Question: Identify the chart type used in this figure.
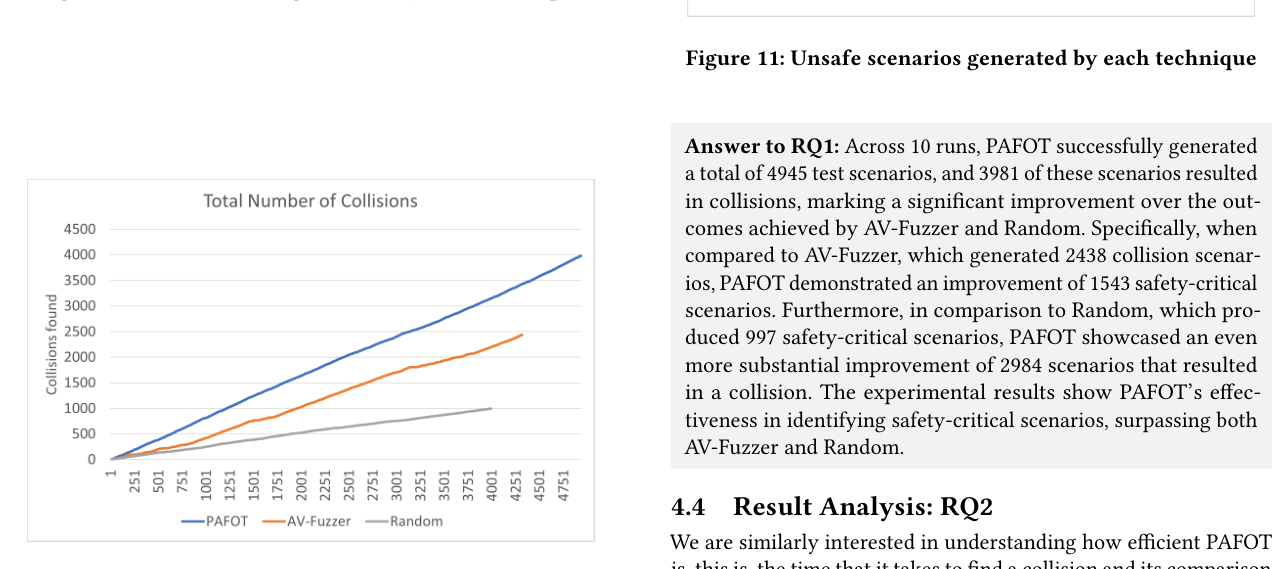
Answer: line